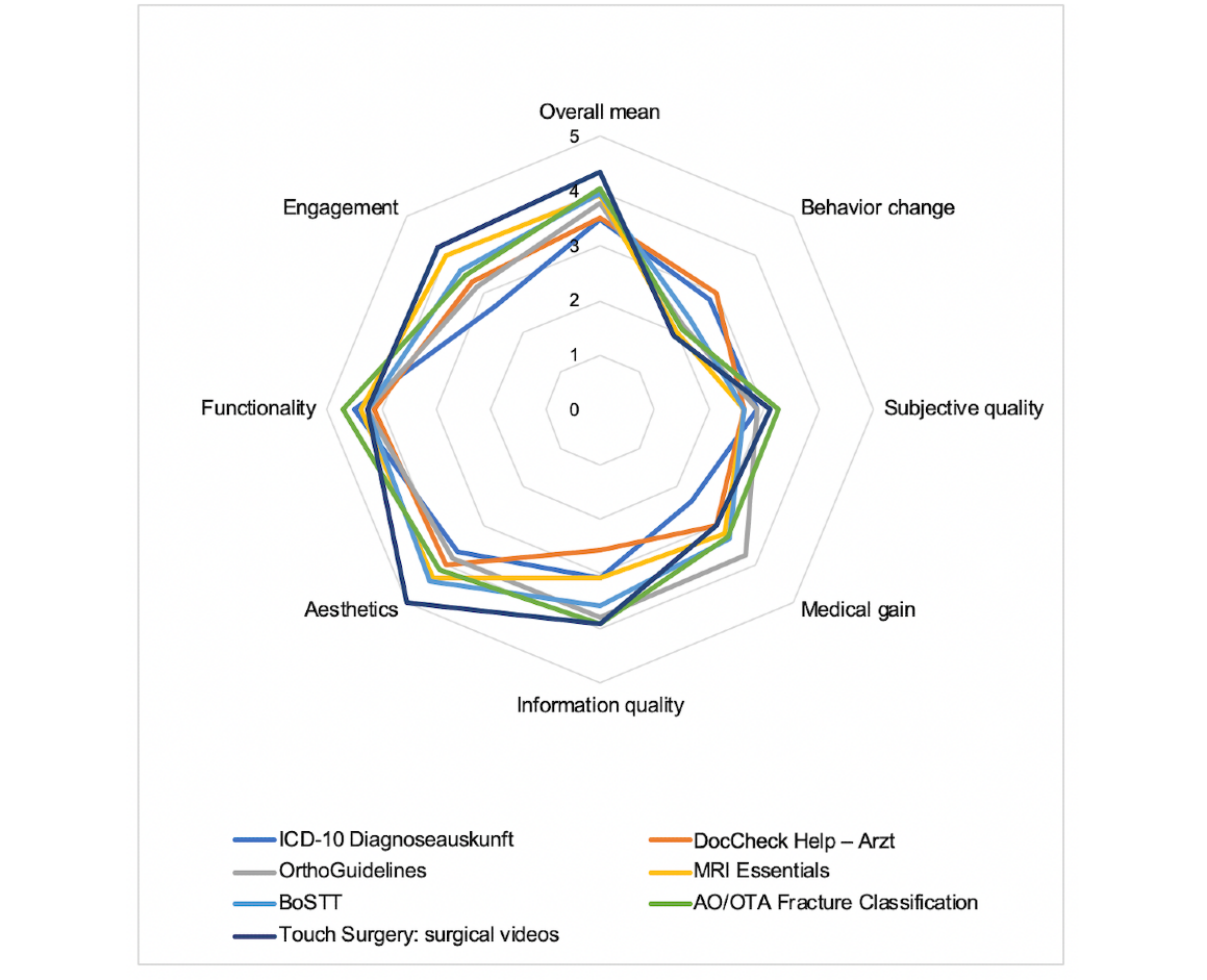
Figure 4. Mean section ratings for trusted apps using the “MARS-G”. Every single app was ranked by two raters. AO/OTA: Arbeitsgemeinschaft für Osteosynthesefragen/Orthopedic Trauma Association; BoSTT: bone and soft tissue tumors-case studies; ICD-10: International classification of diseases, tenth revision; MRI: magnetic resonance imaging; MARS-G: German Mobile App Rating